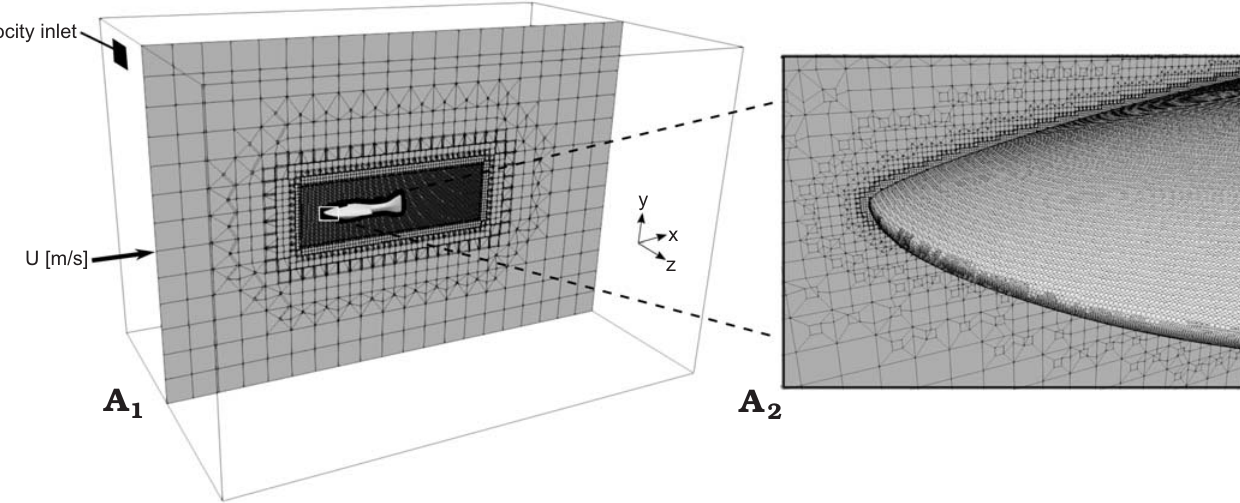
Fig. 1. Box-shaped flow domain, mesh and coordinate system used for computational fluid dynamics (A